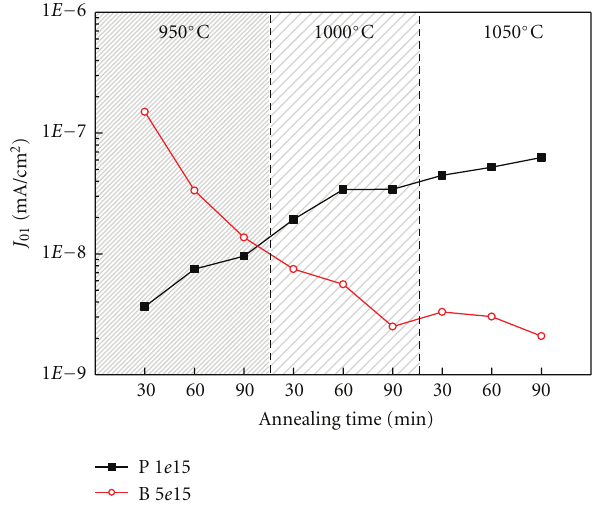
Figure 6: J 01 of ion-implanted samples with di ff erent annealing conditions measured by Dark IV.